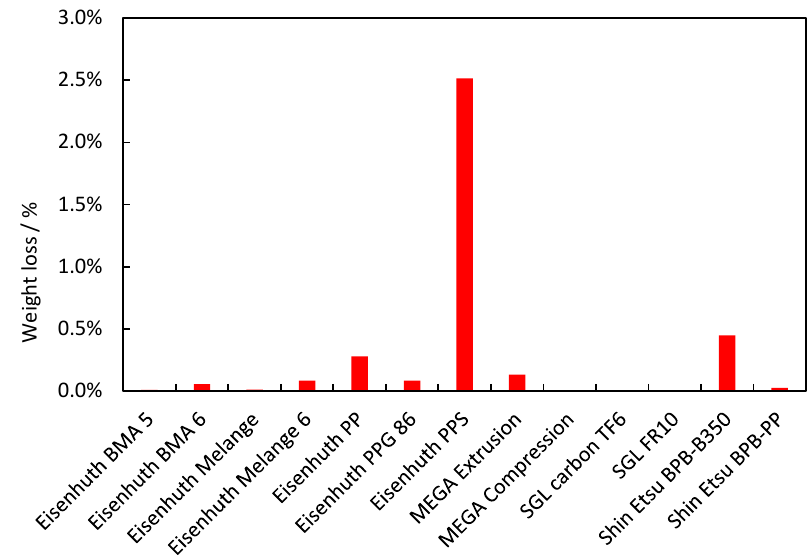
Figure 13. Chemical degradation extent of the BPs tested.